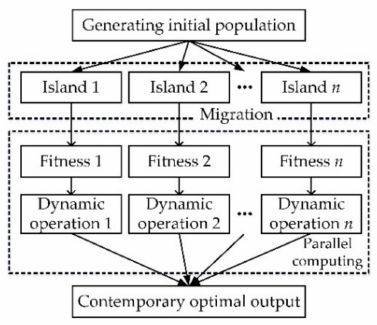
Figure 3. θ * searching procedure with